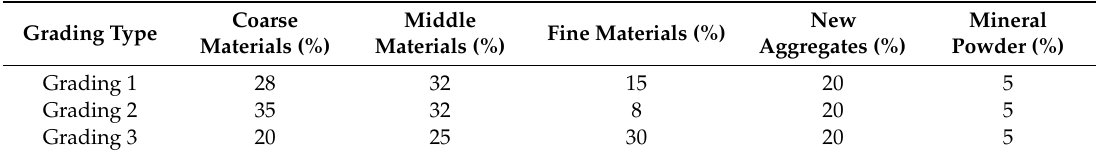
Table 3. Gradation